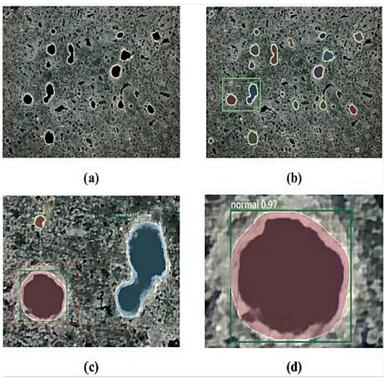
(a) Input image, (b) output image, (c) zoomed-in area in the green box in (b), and (d) zoomed-in area of the red dash-lined box showing details of a single air void structure with a label indicating instance mask and segmentation accuracy. The colour of the mask represents the probability of the accuracy of the detection bounding box using the colour bar. (For interpretation of the references to colour in this figure legend, the reader is referred to the web version of this article.) Image reproduced from